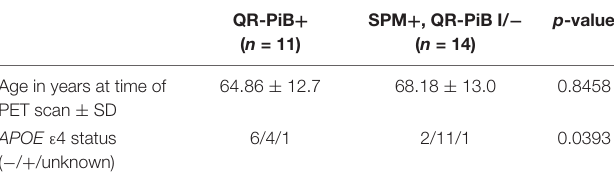
TABLE 7 | QR-PiB positive vs. statistical parametric mapping (SPM) positive, QR-PiB